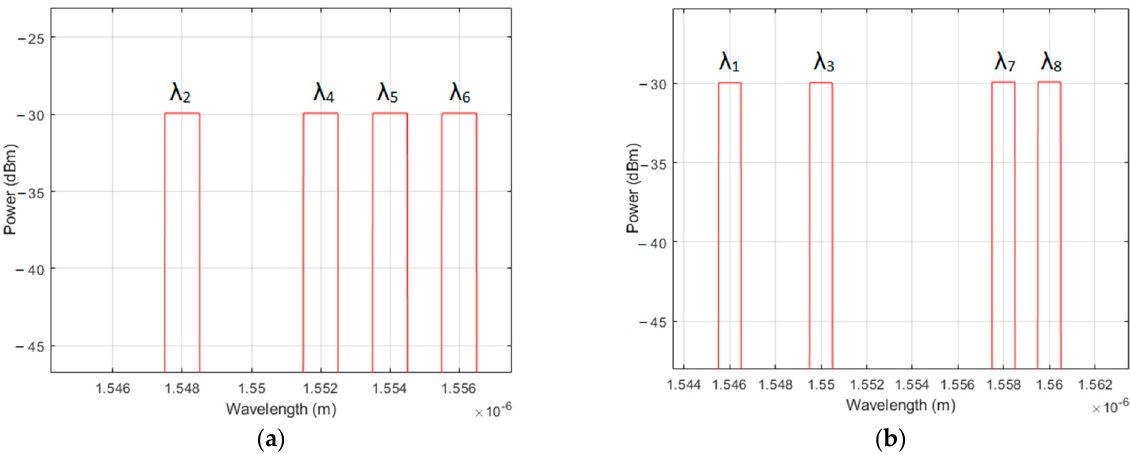
Figure 8. Output spectra before photodetection for the mismatch decoder when bit “0” was transmitted: ( a ) total signals at the upper branch; ( b ) total signals at the lower branch.